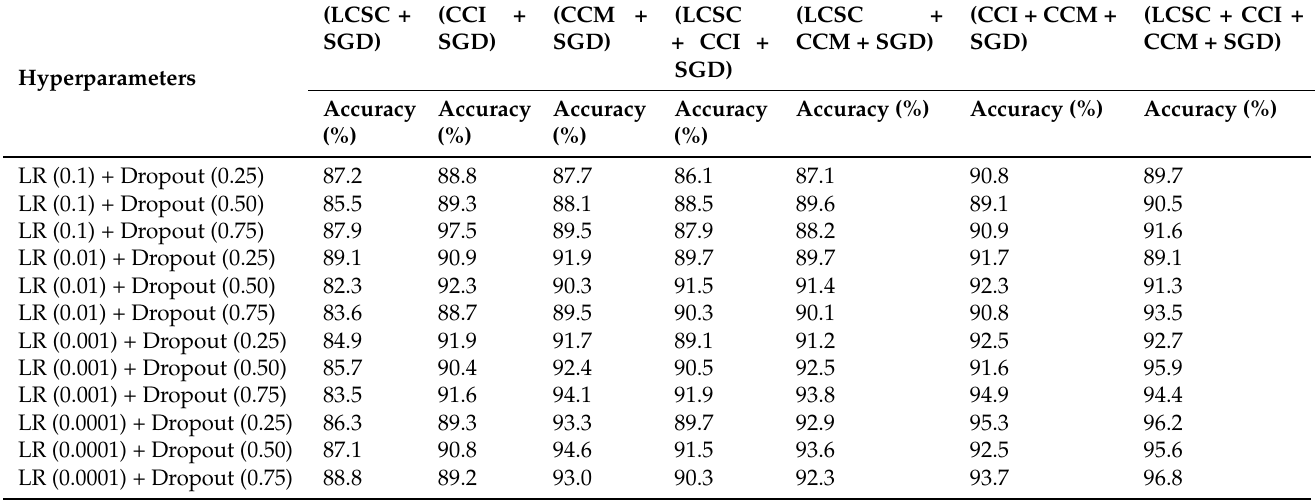
Table 10. Performance evaluation of our proposed model based on different hyperparameter tuning on our dataset with SGD